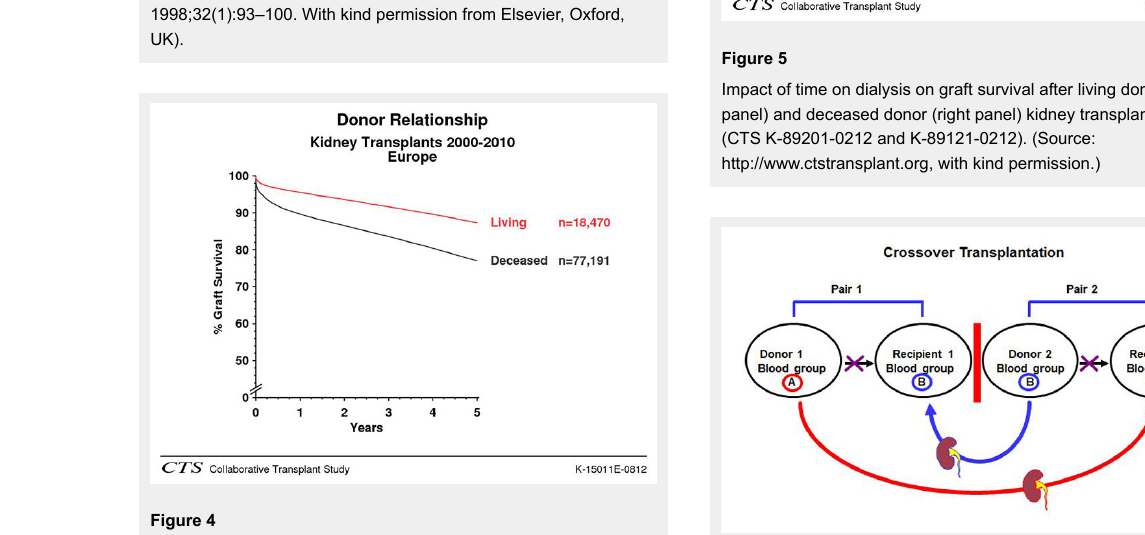
Comparison of graft survival between living donated kidneys and kidneys from deceased donors in Europe between 1998 and 2010 (CTS K-15011E-0212). (Source: http://www.ctstransplant.org, with kind permission.)